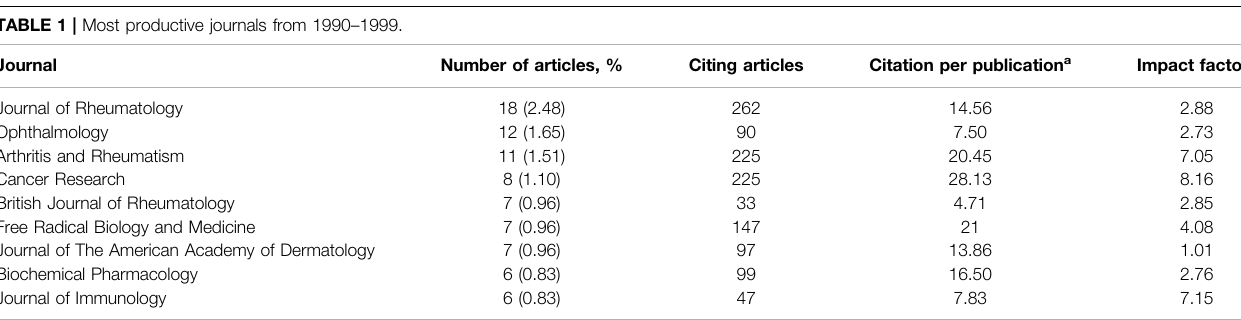
TABLE 1 | Most productive journals from 1990 – 1999.